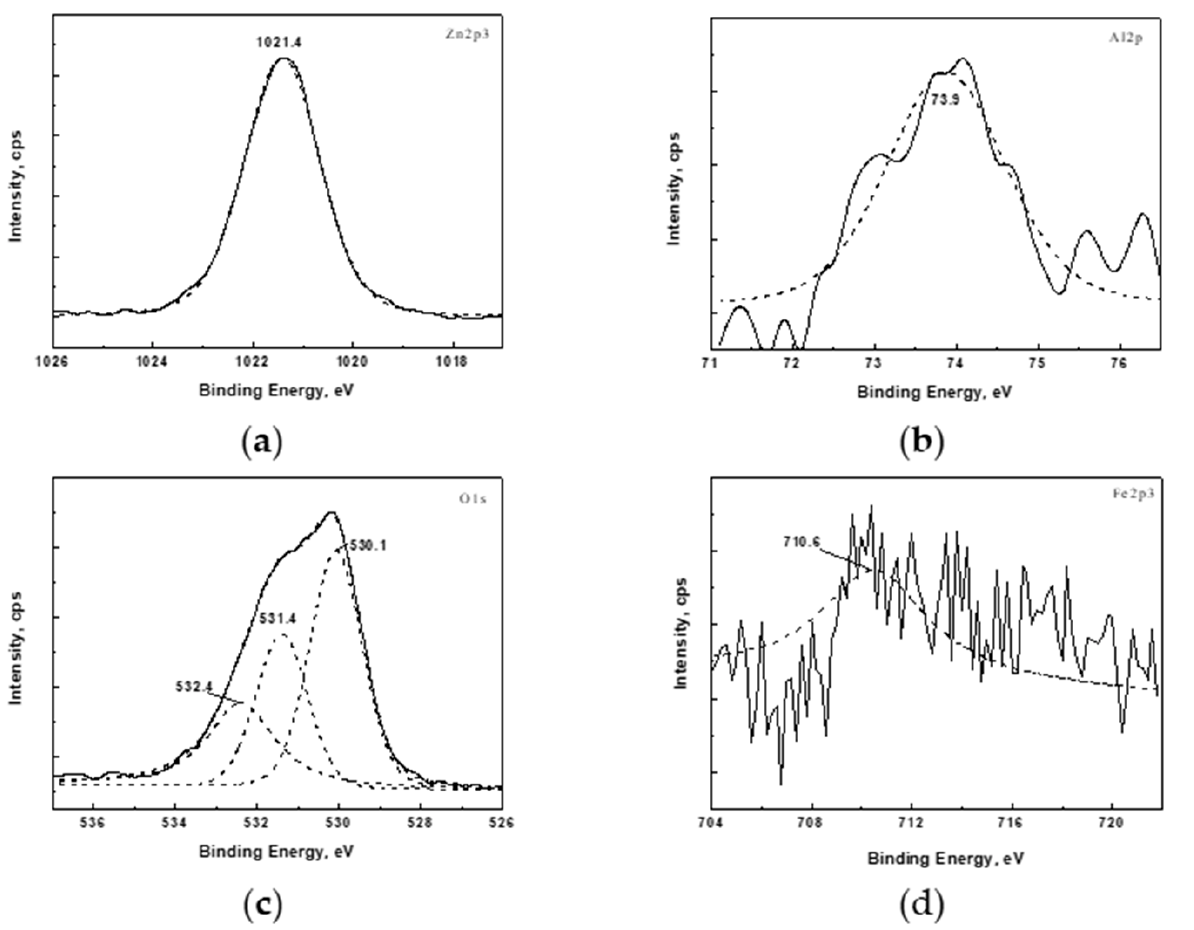
Figure 5. XPS spectra of Zn 2p3, O 1s, Al 2p, and Fe 2p3 peaks in codoped (Al:Fe = 1) film. ( a ) Zn 2p3, ( b ) O 1s, ( c ) Al 2p, ( d ) Fe 2p3.